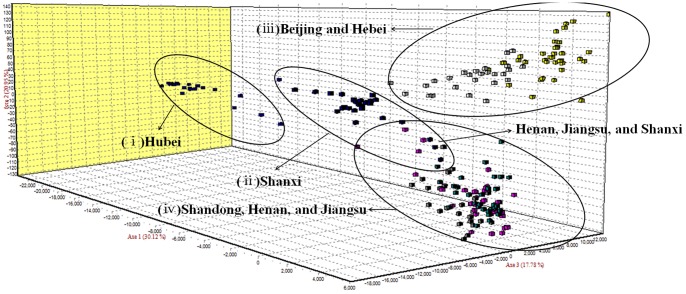
Three-dimensional factorial correspondence analysis (FCA) of S. avenae sampled in 2012.The circles indicate populations that cluster according to geography.